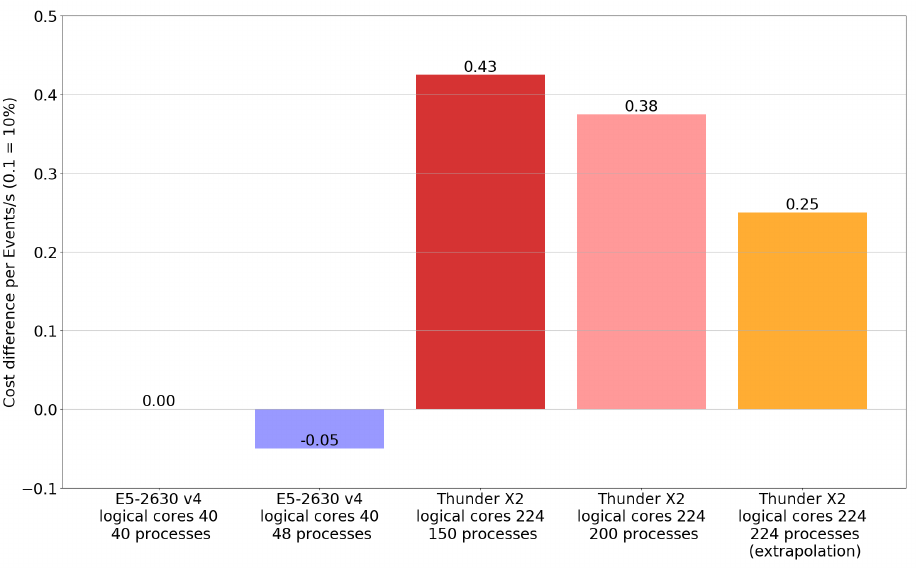
Figure 2: Cost-performance estimation based on the price for buying a